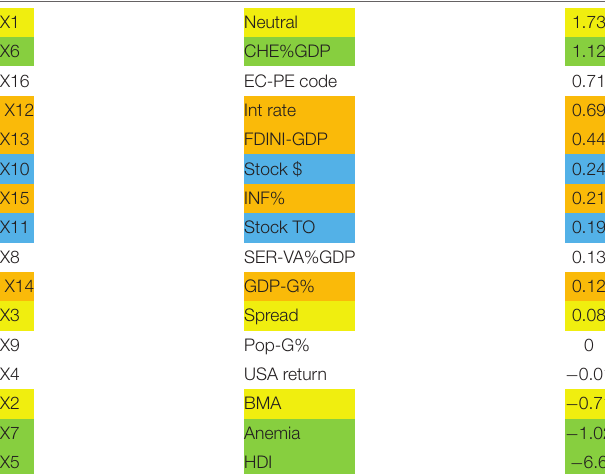
TABLE 18 | Feature Importance in the UAE Testing Set.